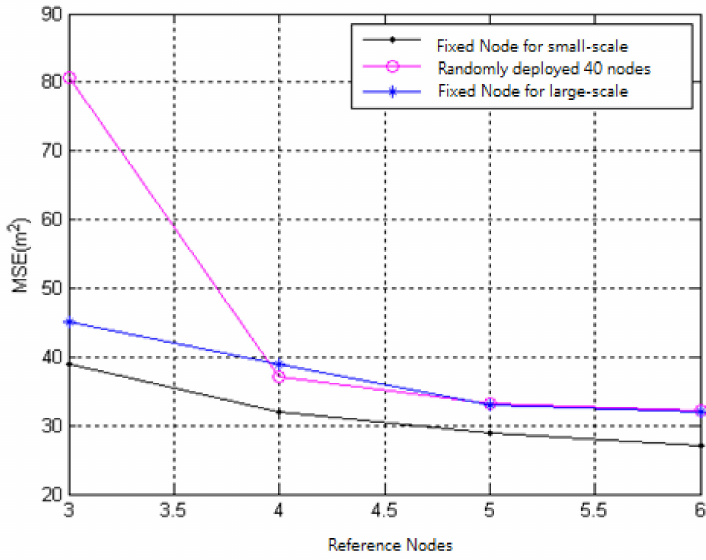
Figure 11. Comparison of three to six fixed and random reference nodes.